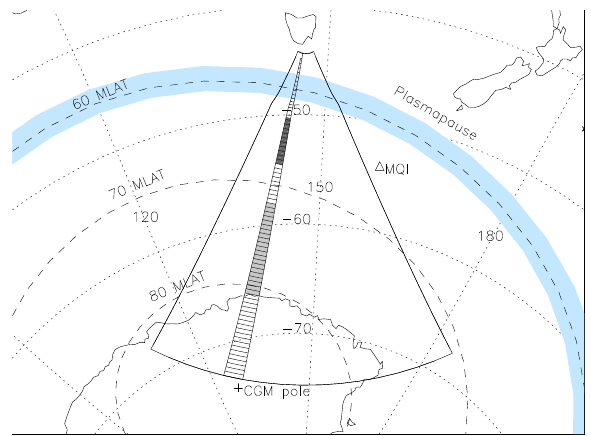
Fig. 1. Boundaries of TIGER field of view (solid line). Dotted lines correspond to geographic coordinates, and dashed lines depict CGM latitude. High-time-resolution data used in this paper were obtained with beam #4 (mesh area) pointing toward the CGM pole (+). Light gray shading corresponds to gates 35–55, where most of the sea-scatter echoes were observed during 20:00–24:00 UT on 28 September 2000 (interval analysed in detail in this paper). Dark gray shading corresponds to the ionospheric reflection regions for those gates (half the apparent range). The location of the Mac- quarie Island (MQI) magnetometer site is shown by a triangle. The light blue shading corresponds to a model plasmapause position at 12 MLT derived from Carpenter and Anderson